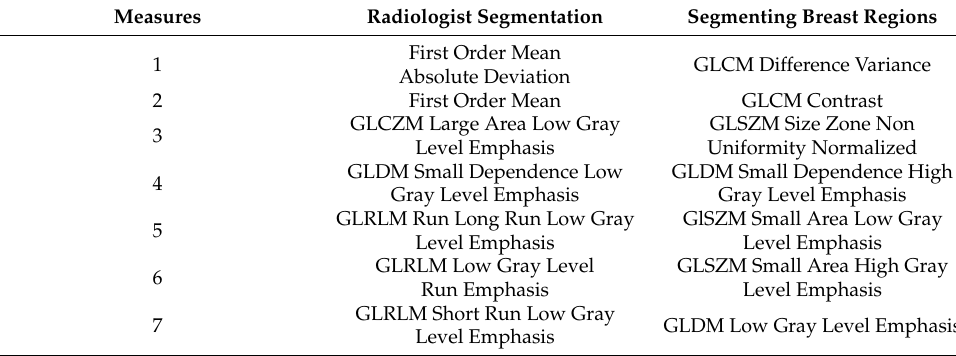
Table 4. Comparison between models with MS1 and MS2